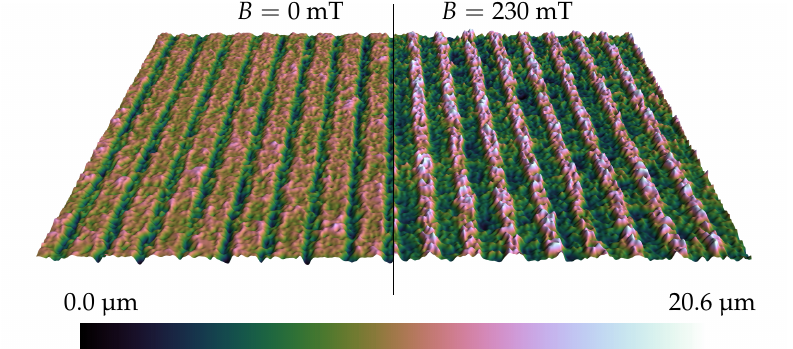
Figure 14. Effect of a magnetic field on surface morphology of a lamellar MAE structure from material M (left: B = 0 T | right: B 230 mT). The vertical scale is exaggerated for a better visualization. ≈ Shown area is 1.72 1.29 mm 2 . Laser setting is 1 × ×